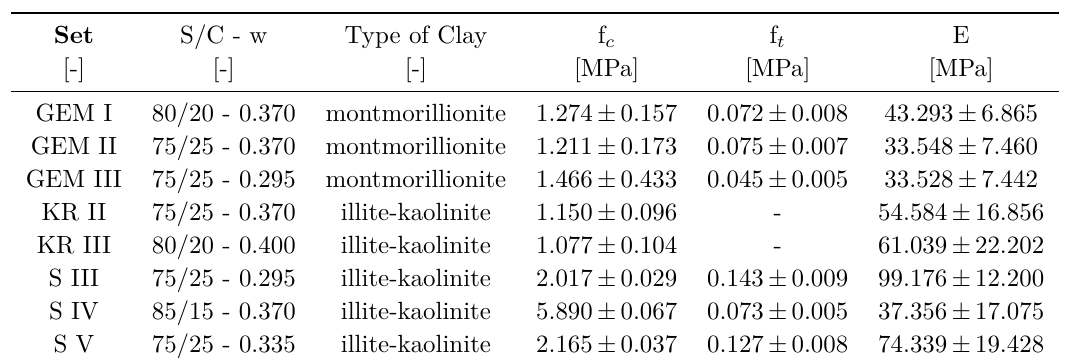
Table 2. Measured modulus of elascity E .